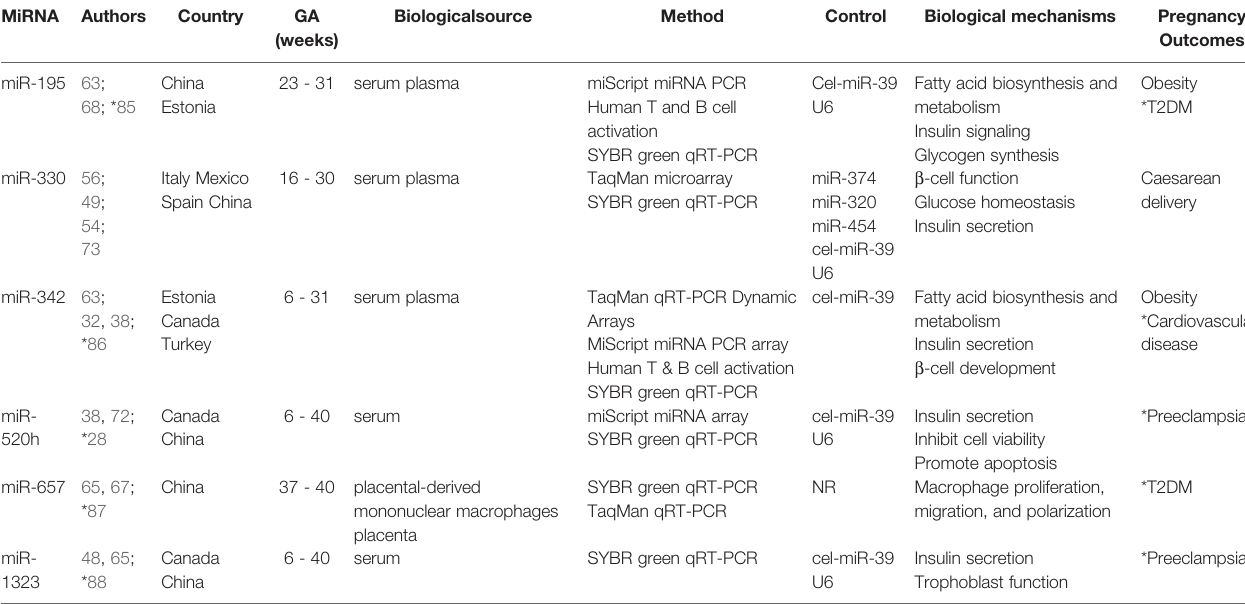
TABLE 2 | MicroRNAs upregulated during GDM in two or more studies. MiRNA